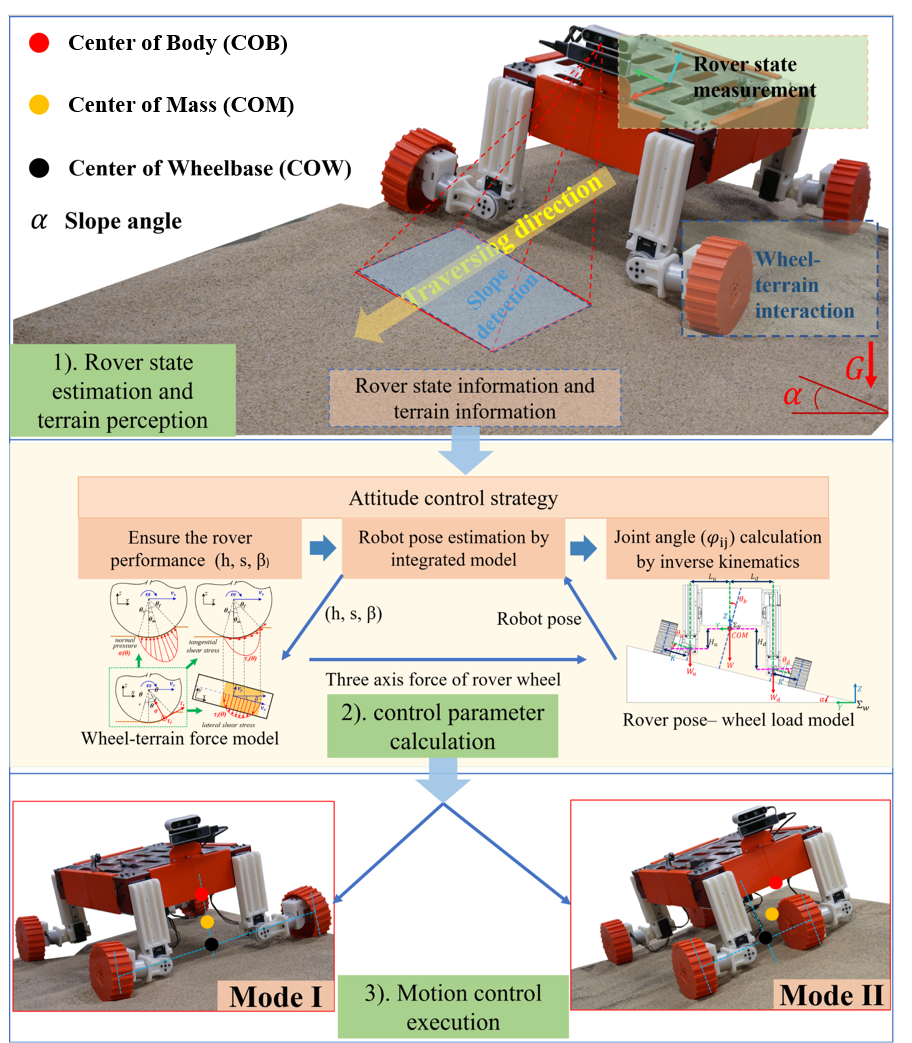
Figure 1. Introduction to the soft terrain slope traversing task using our ROMA-Sloper rover as an example. This task can be divided into three parts: (1) rover state estimation and terrain perception, (2) rover attitude control parameter calculation, and (3) motion control execution. ROMA-Sloper has 4 wheels, 12 motors, 4 F/T sensors and an Intel T265 camera (with built-in visual odometry function) and an Intel D435i RGB-D camera for terrain